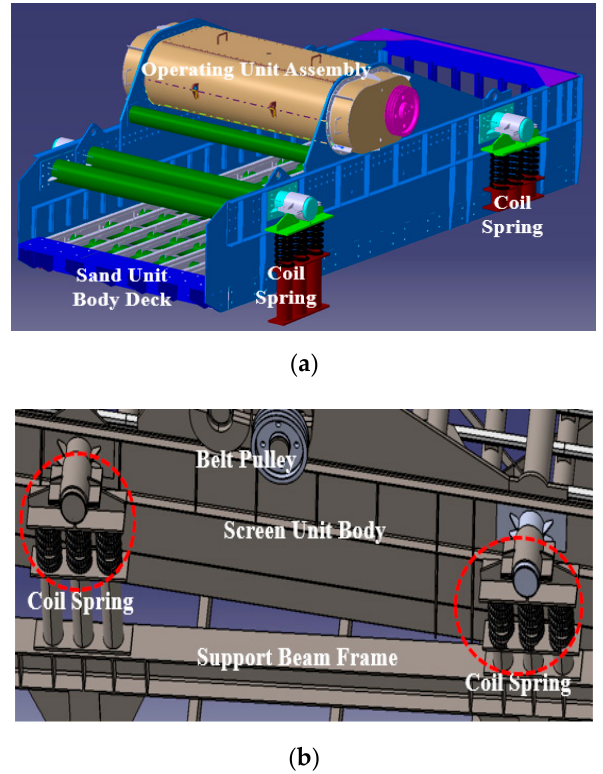
Figure 3. Sand unit assembly and coils spring installed in vibration isolation system: ( a ) Sand unit body and operating part assembly; ( b ) Side view of coil spring installed for screen and sand units.